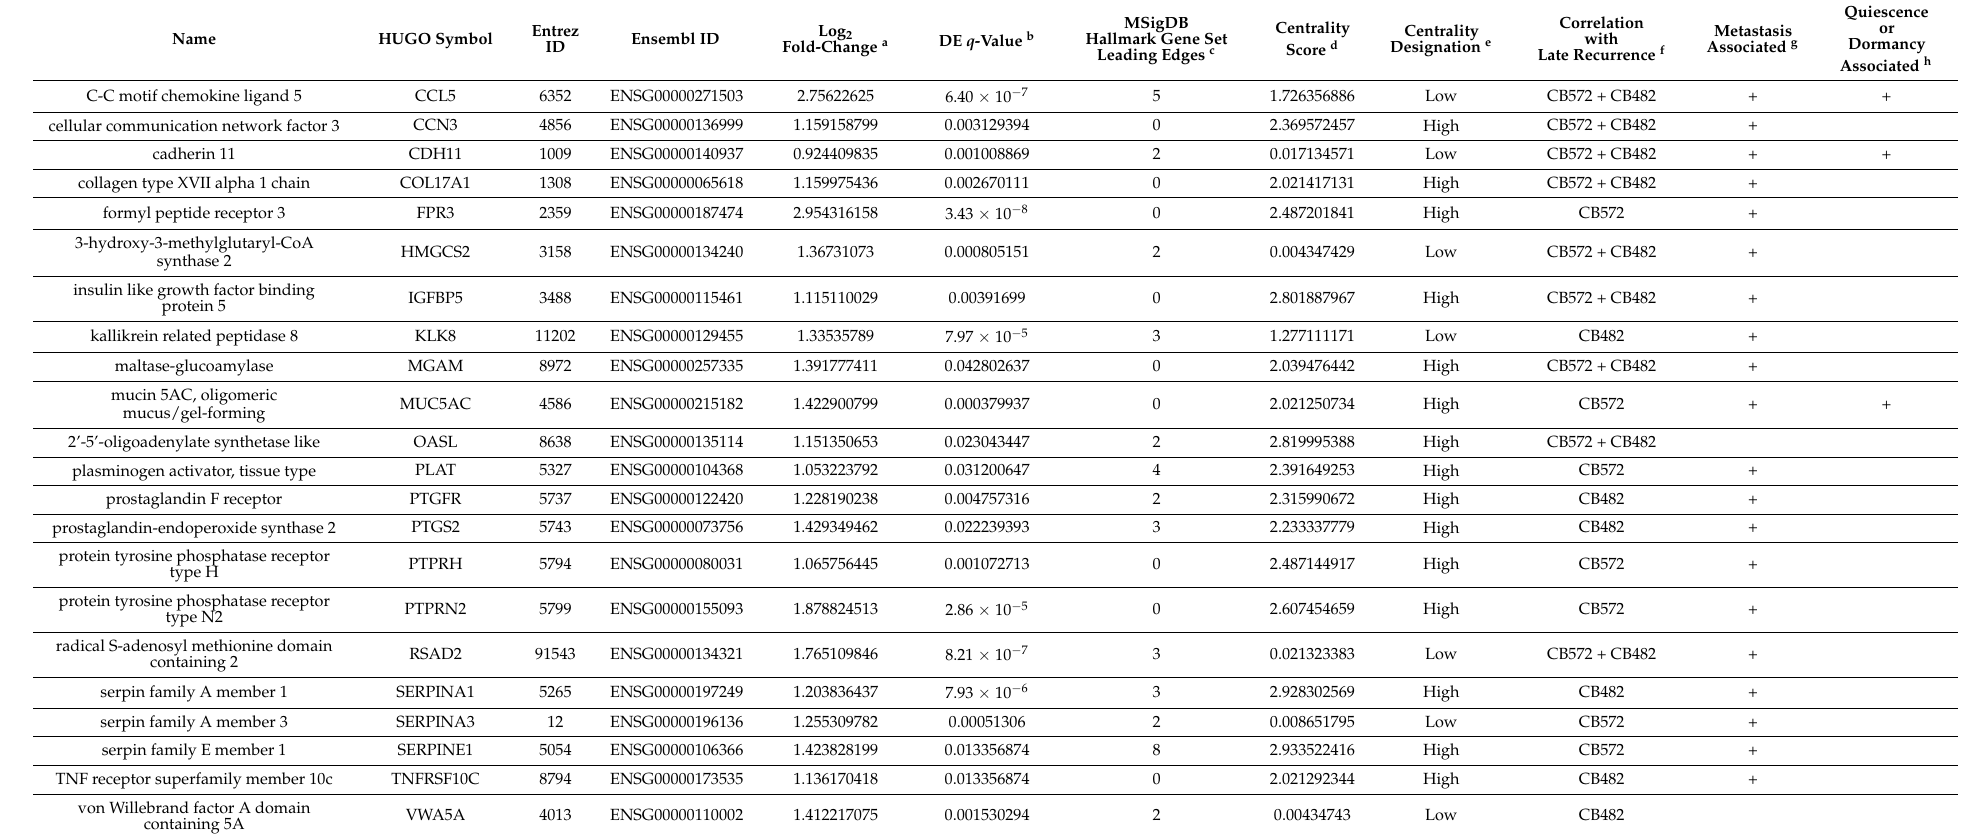
Table 1. Quiescence-Associated Genes with High Functional and Prognostic